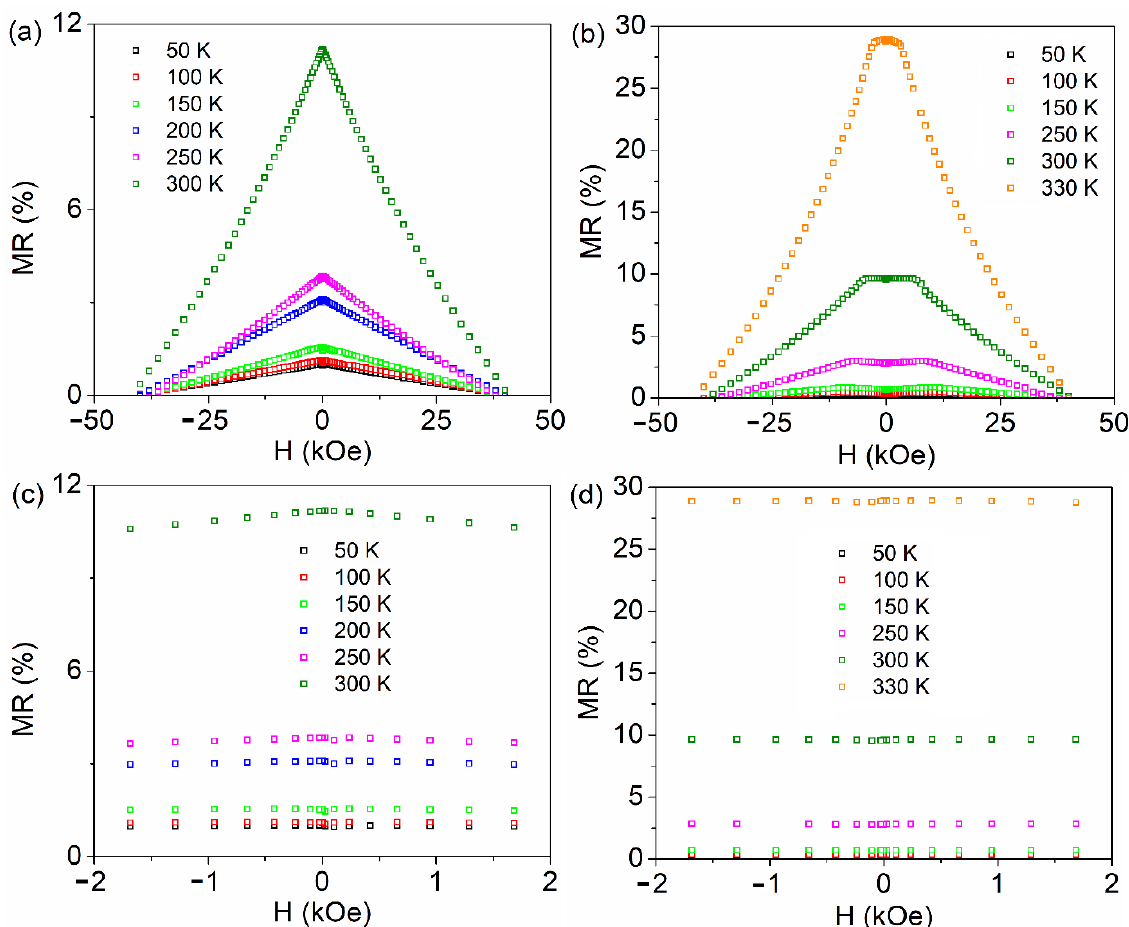
Figure 7. MR curves of LSMO 30 sample collected in parallel ( a ) and perpendicular ( b ) geometry; MR curves collected in parallel ( c ) and perpendicular ( d ) geometry in the low field region.